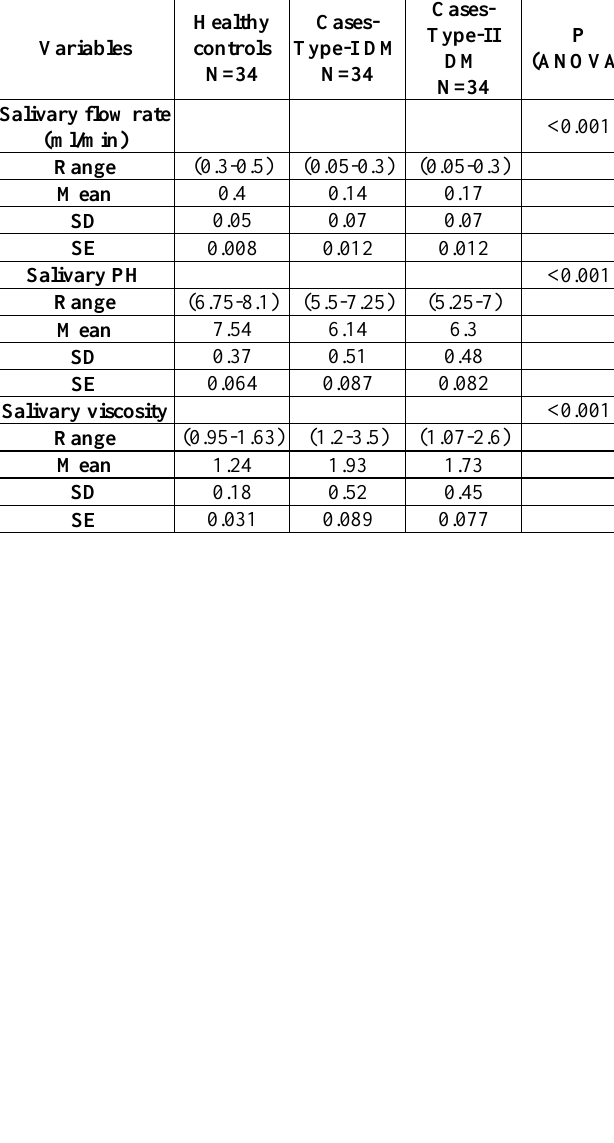
69 Oral Diagnosis